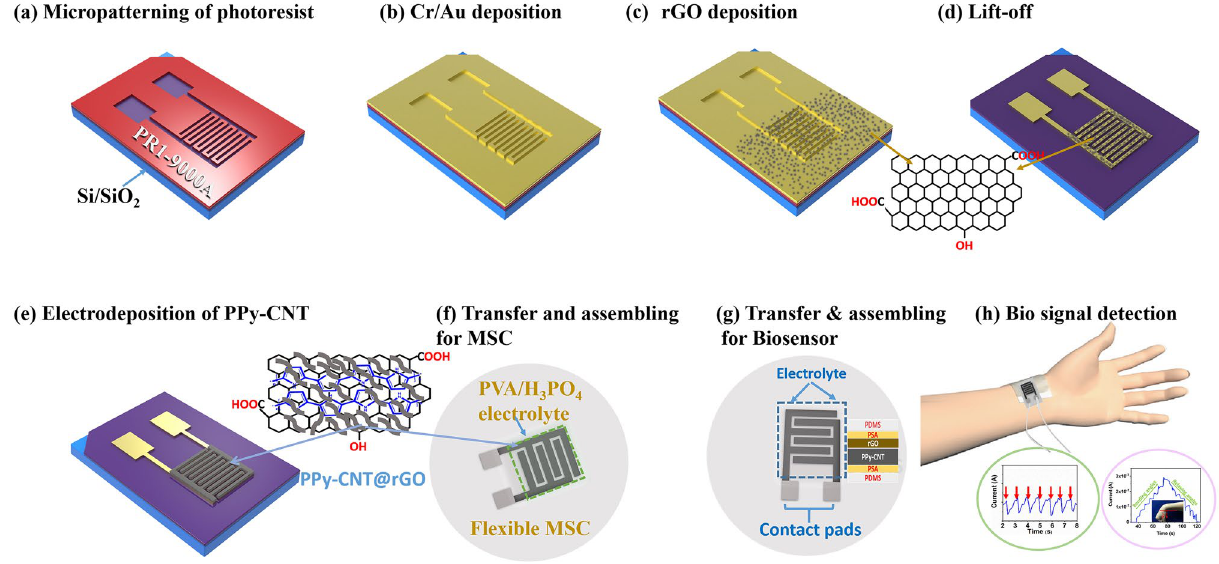
Fig. 1 a - h A schematic of the microfabrication process of PPy-CNT@rGO MSCs and